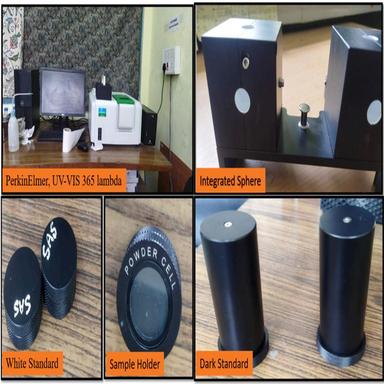
UV-Visible spectrophotometer (PerkinElmer, UV–VIS 365 lambda) setup used for the Optical Studies measurement.